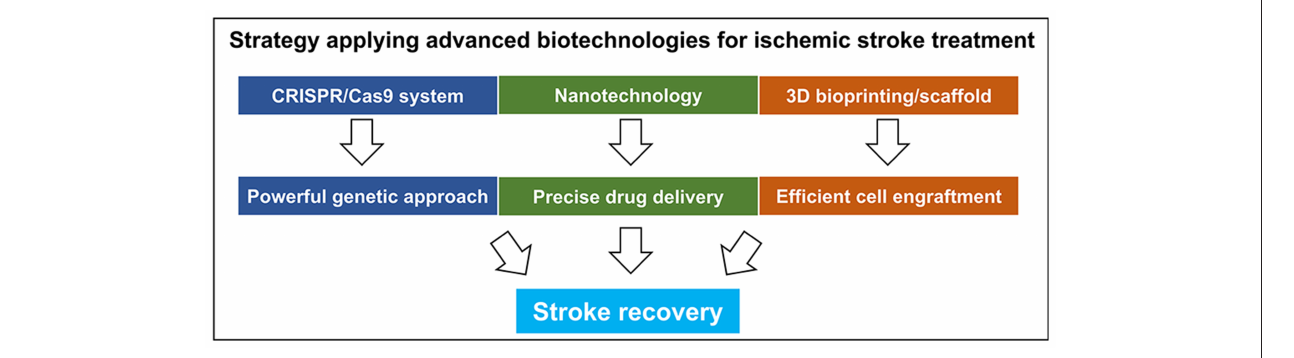
FIGURE 4 | Current advanced biotechnologies for treatment of ischemic